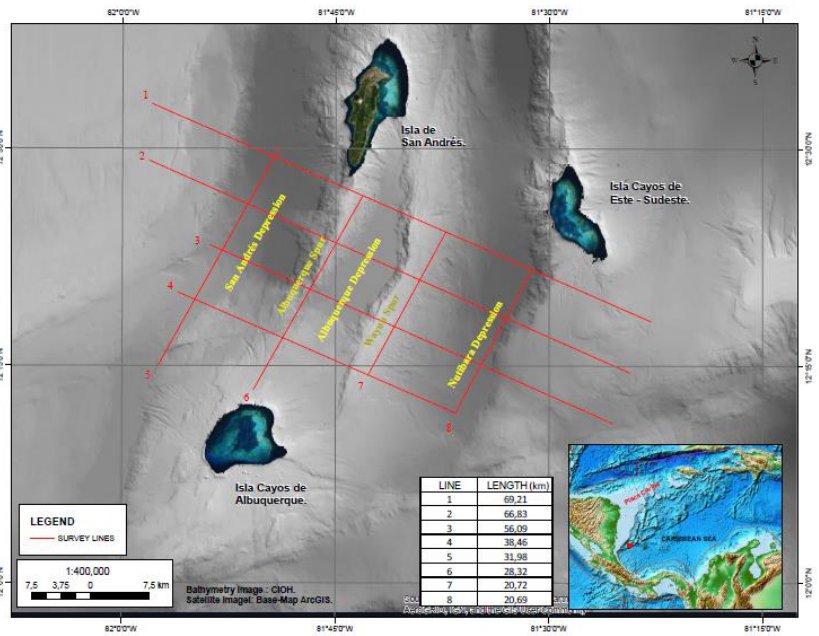
Figure 10. Geometric adjustment of the geomagnetic acquisition.